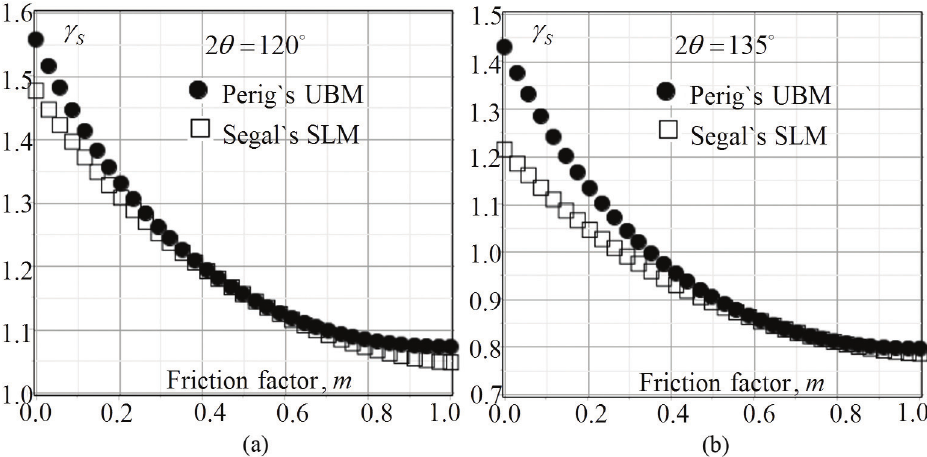
Figure 8. Comparison of Perig’s upper bound (UBM, ●●●) and Segal’s slip lines (SL, □□□) solutions for different values of friction factor m . Computational dependencies for summary plastic shear g ( a , b ) with respect to the friction factor m , derived with UBM and slip line S method (SLM) during ECAE of non-hardening material through Segal dies with channel intersection angles 2 θ =120 ° ( a ) and 2 θ =135 ° ( b